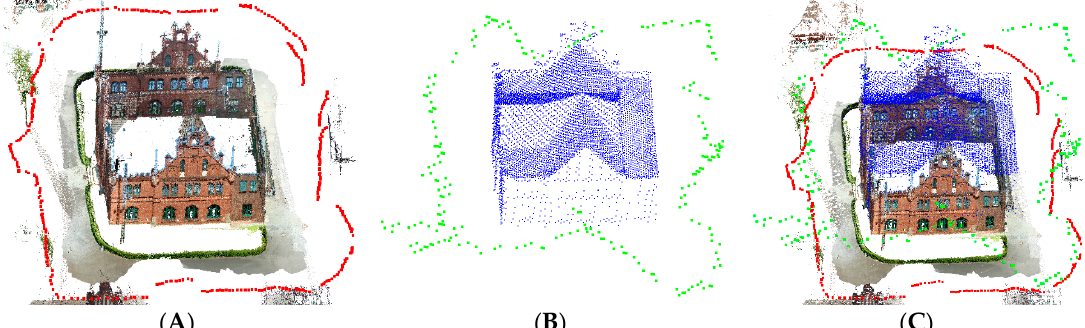
Figure 2. An overview of the initial geolocalization process. ( A ) Camera positions calculated using SfM (red) ( B ) and camera GPS meta-information (green points) aligned using a random sample consensus (RANSAC)-based similarity transformation. Simultaneously, the façade point cloud (textured points) is aligned to the point cloud of the building from the open LiDAR data (blue points) by applying the calculated 2D similarity transformation parameters in the horizontal direction and a vertical translation. ( C ) The alignment results.